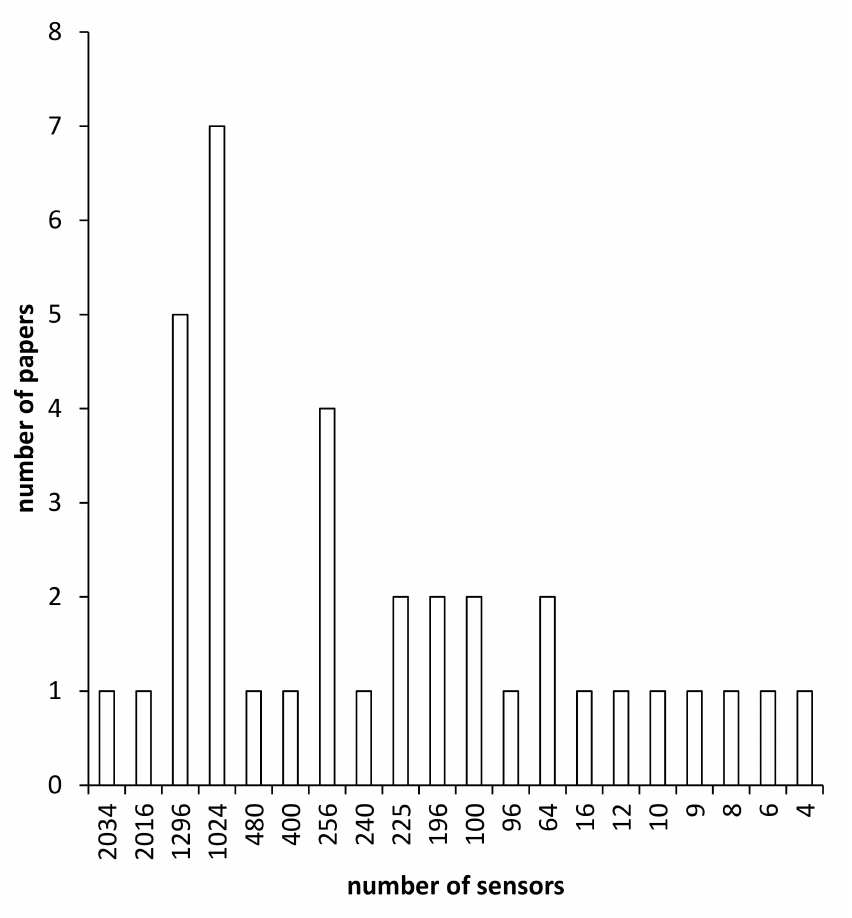
Figure 4. Comparison of di ff erent pressure measurement systems used in publications with respect to the number of sensors being utilized. Please note: those with large numbers of sensors are generally the “pressure mats”, discussed in the adjacent